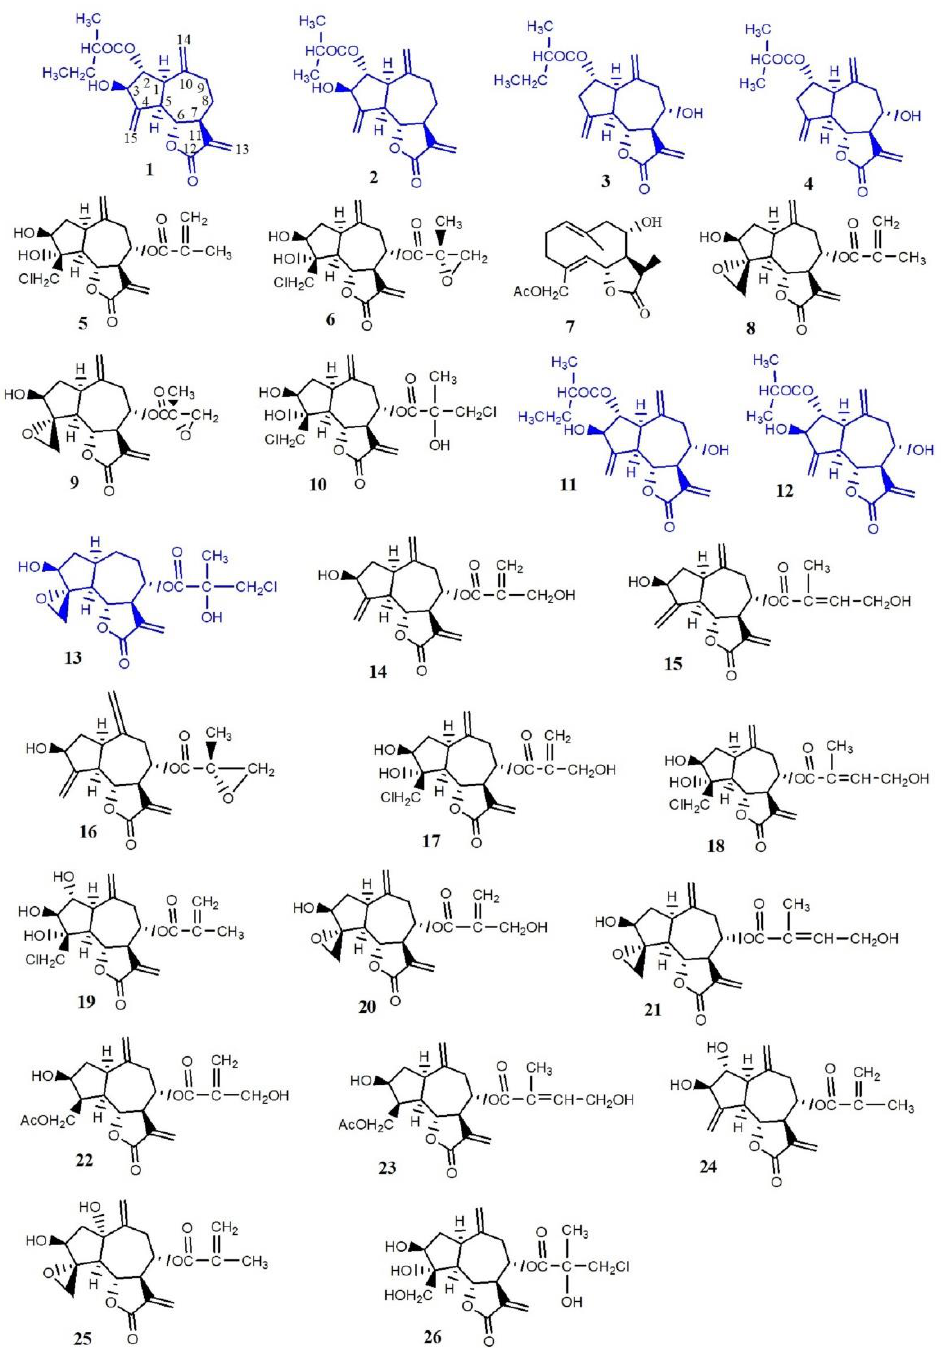
Figure 1. Chemical structures of compounds with features responsible for their antifungal properties: 1 . cebellin